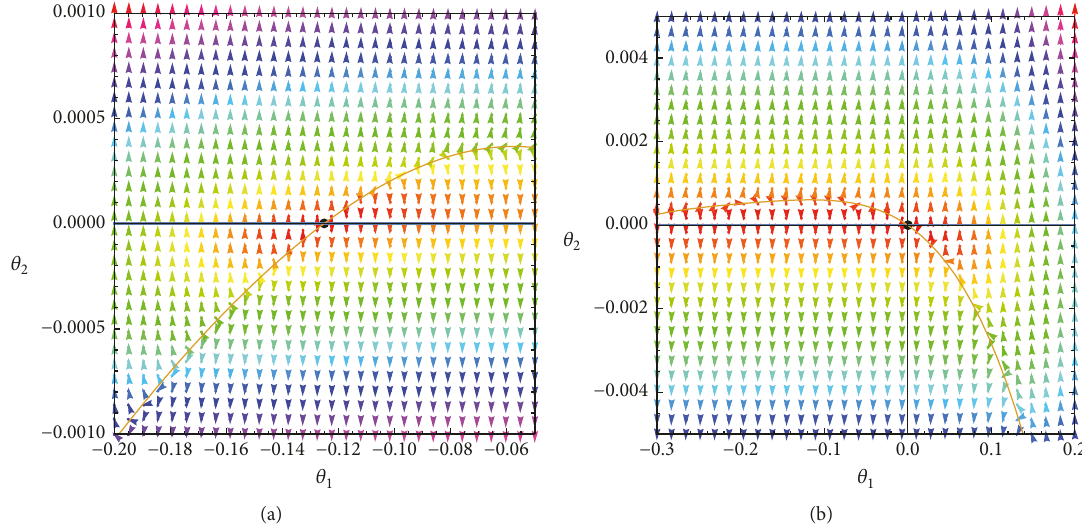
Figure 5: Phase plots indicating the trajectories around the equilibrium points (54) and (55) for 𝜃 𝑎 = 0.2 , 𝑟 ∗ = 1/1.75 , and N 𝑟 = 1 . (a) has N = 0.1 whereas (b) has N = 0.01 . (a) is a closer view of the second equilibrium 𝑐 𝑐